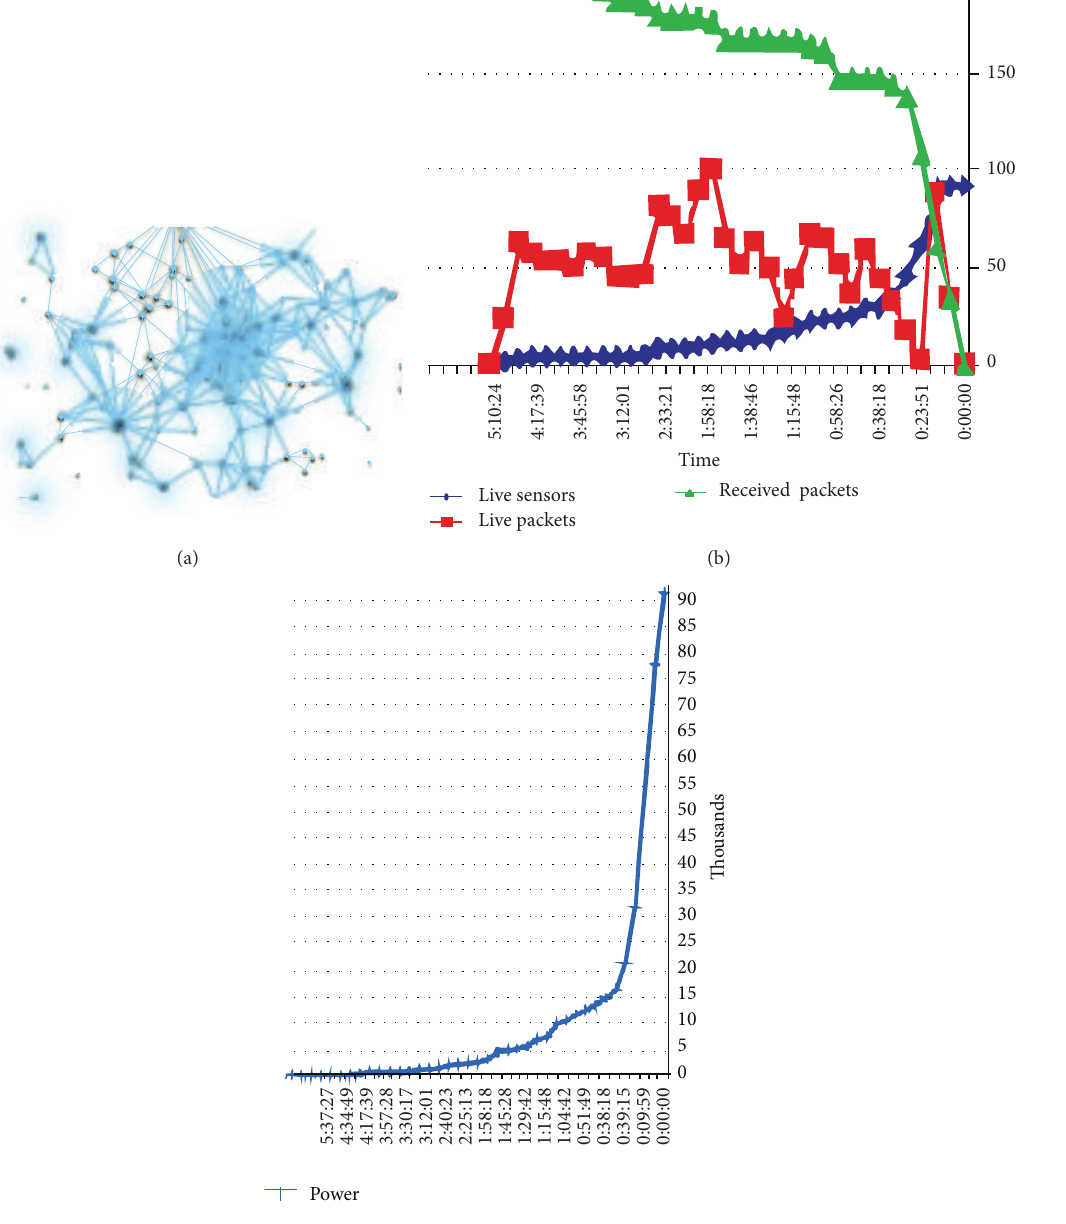
Figure3:(a)Nodeplacementscheme.(b)Comparisonbetweennumberofavailablesensors,liveandreceivedpacketsexistinginthenetwork. (c) Comparison between mount of power and lifetime of